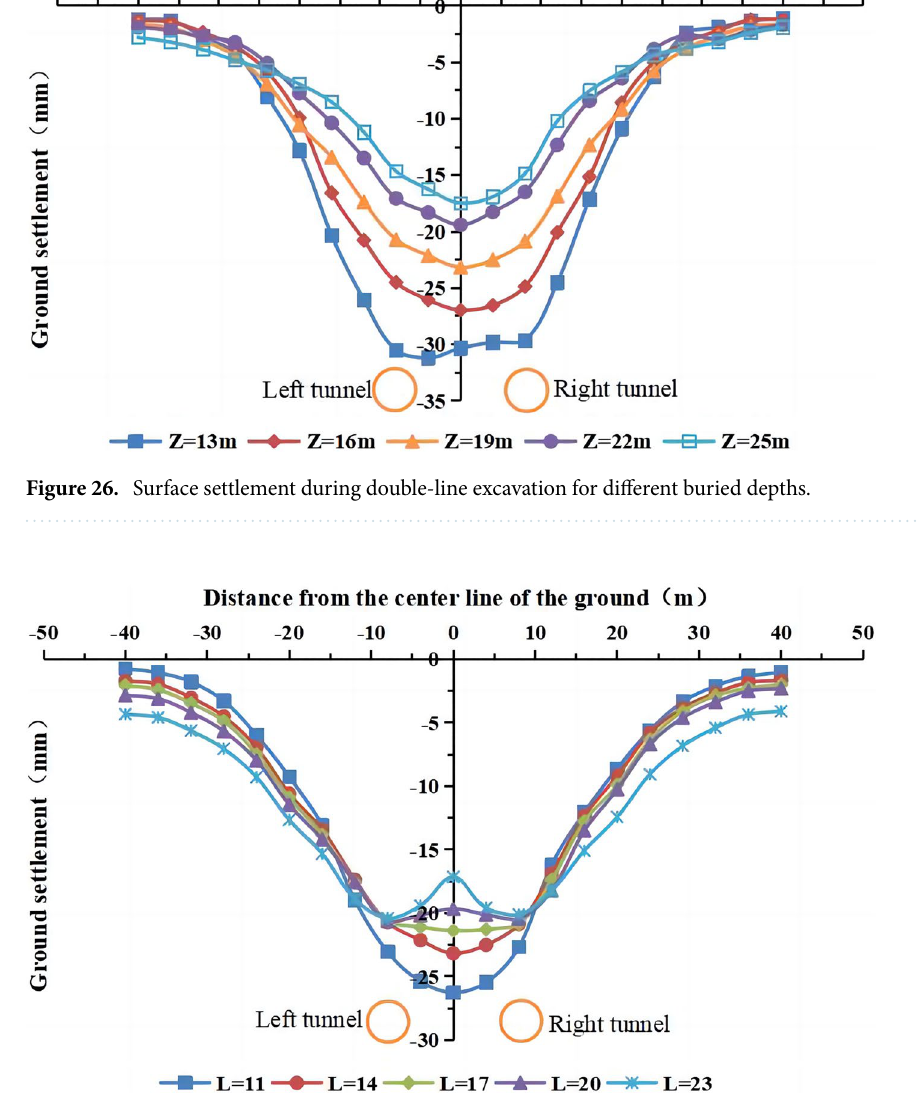
Figure 27. The surface settlement for different distances between the two